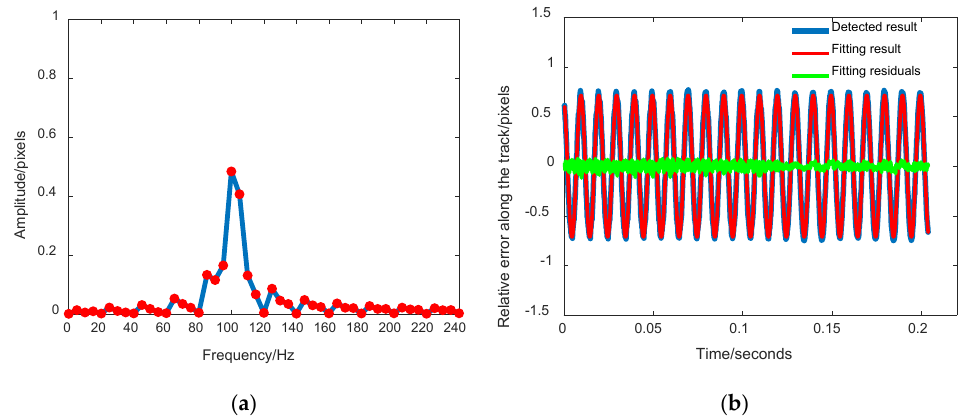
Table 3. Fitting results of relative jitter error curves of three different frequencies by sequential dis- parity maps.